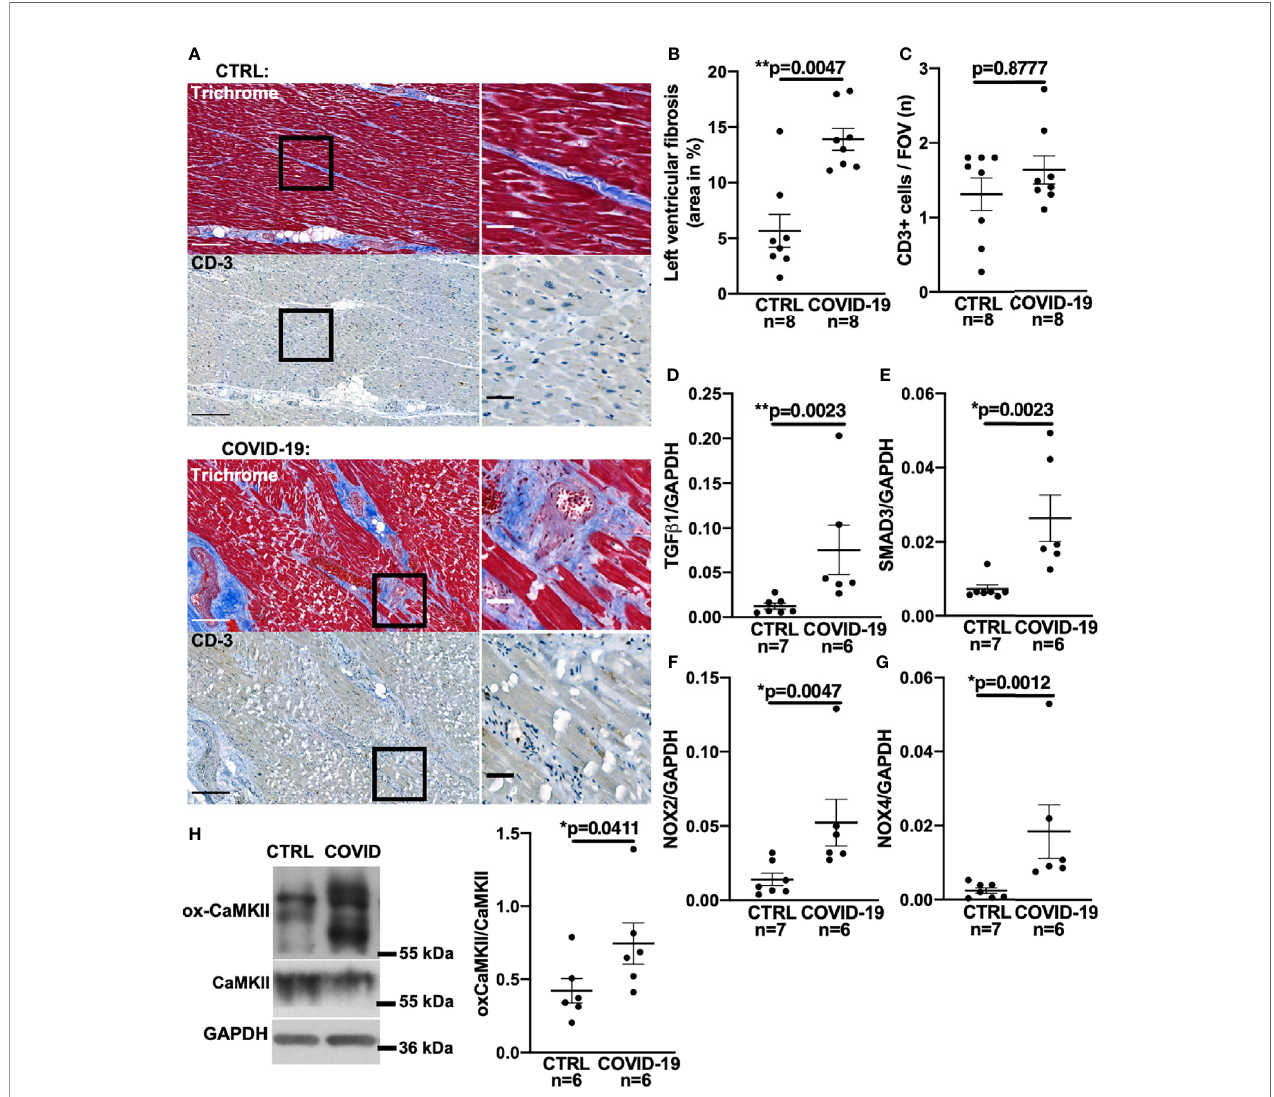
FIGURE 1 | Increased left ventricular fi brosis in deceased patients with COVID-19. (A) Original histochemical stainings using trichrome (upper panels) and immunohistochemical stainings for CD3 (lower panels) of adjacent sections of left ventricular tissue. Left images with scale bar 250 µm. Right images show a magni fi ed view of the areas marked with a solid black border (scale bar 50 µm). (B) Mean ± SEM data of left ventricular myocardial fi brosis area shows increased myocardial fi brosis in autopsied COVID-19 patients compared to control (CTRL; Mann-Whitney test). (C) Mean ± SEM number of CD3-positive cells per fi eld of view (FOV) shows no signi fi cant difference between COVID-19 patients and controls (Mann-Whitney test). (D – G) Mean levels of mRNA expression of TGF- b 1 (D) , SMAD3 (E) , NOX2 (F) and NOX4 (G) detected by qPCR in left ventricular myocardium taken from deceased COVID-19 patients and controls. Compared to controls, mRNA expression of TGF- b 1, SMAD3, NOX2 and NOX4 was signi fi cantly increased in autopsied COVID-19 patients (all tested with Mann-Whitney). (H) Original western blot (left panel) and mean densitometric data (right panel) for oxidized CaMKII (ox-CaMKII) expression normalized to CaMKII. In myocardium of patients with COVID-19, oxidized CaMKII expression was signi fi cantly increased (Mann-Whitney